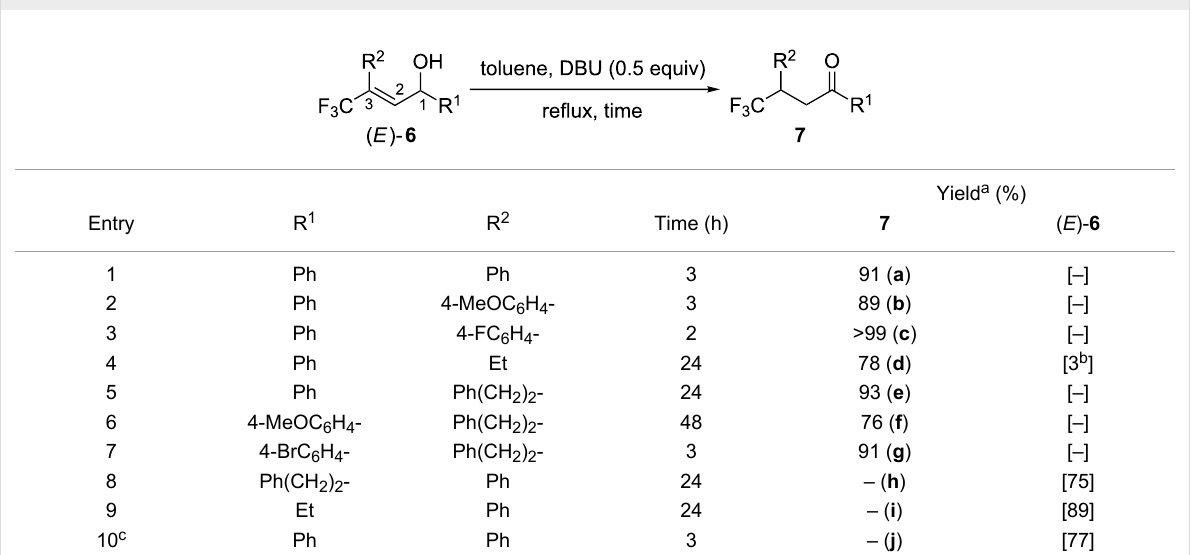
Table 3: Transformation of allylic alcohols ( E )- 6 to the corresponding ketones 7